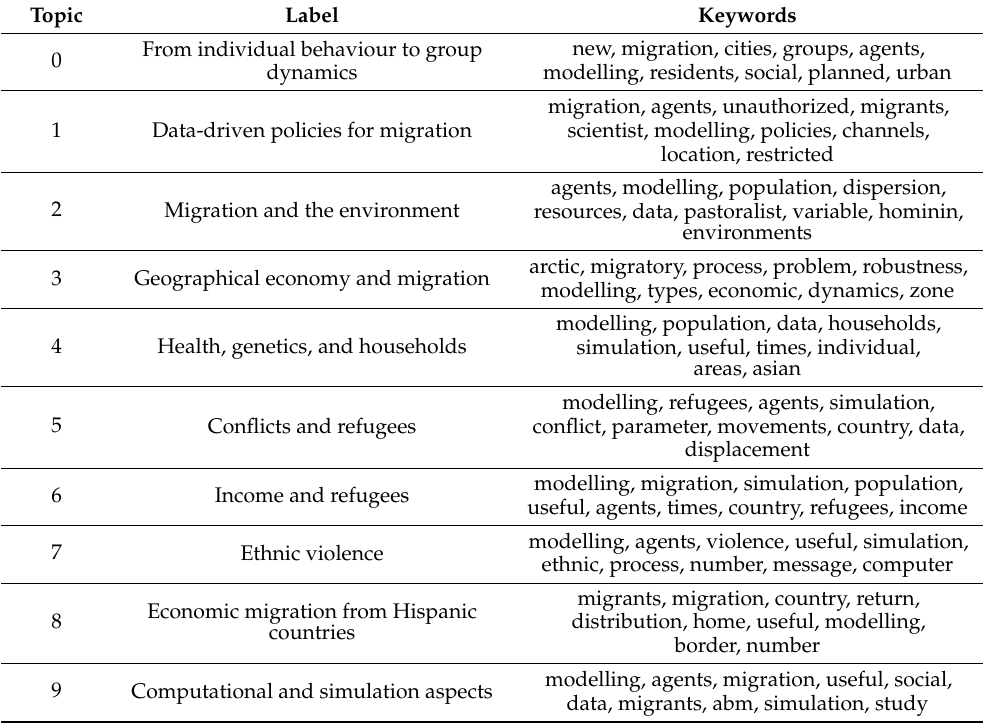
Table 5. Topics extracted from the corpus of articles.